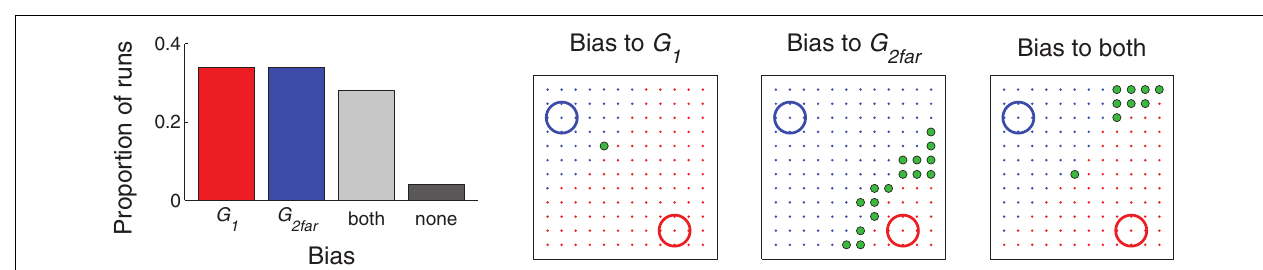
FIGURE 6 | Example neural activity for selected neurons from D1, SNr, and Cortex (M) at different points in training for a model with low levels of noise ( σ = 0 . 1) added to Cortex (M) neuron activity (see text for details). This figure is plotted in a manner similar to that of Figure 3 . Neurons are colored according to their spatial location in the grid (top left). The red neuron corresponds to the reinforced movement that hit target G 1 in this